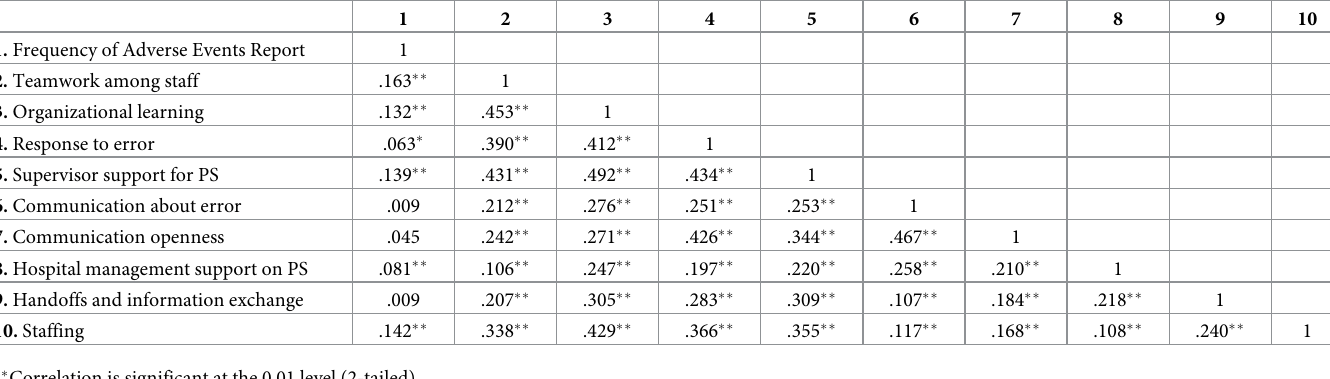
Table 5. Correlations between frequency of adverse events reported and patient safety